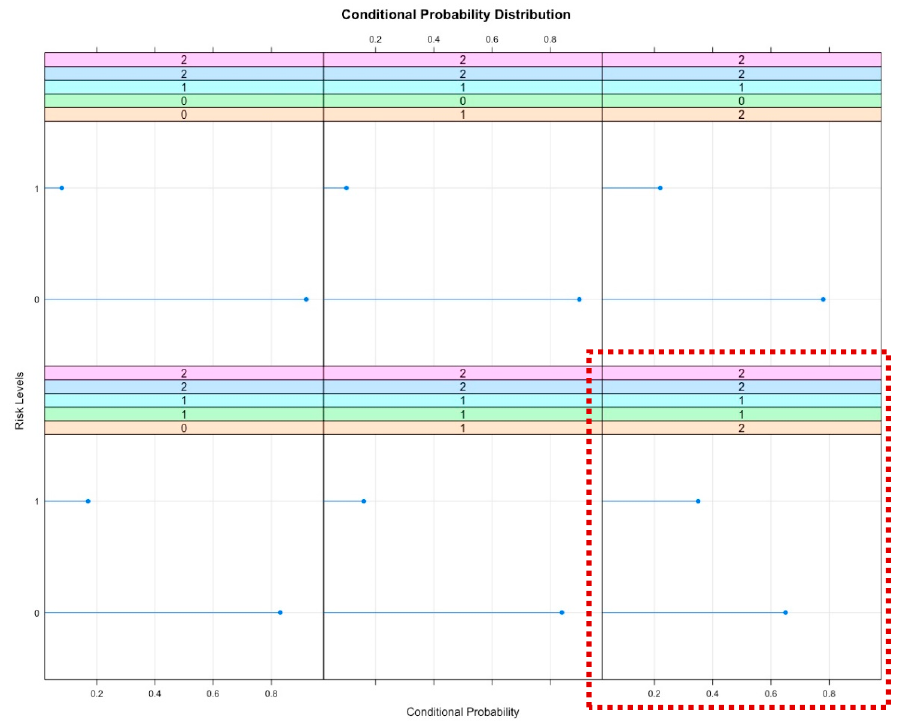
Figure 7. The conditional probability distribution of ‘Cargo Theft Risk’ node using the combination of structure learning algorithm with HC, the score function with k2, the parameter learning algorithm with Bayesian posterior probability estimation and five as the maximum number of father nodes. The subfigure in the bottom right corner (highlight in the red and dotted rectangle) of Figure 7 indicates that the cargo theft risk is highest when ‘Cargo Weight Deviation’ equals 2, ‘Means of Payments’ equals 2, ‘Reformed or Not’ equals 1, ‘Arrival time’ equals 2 and ‘Weather’ equals 1. In other words, this means that when a reformed truck arrives at the port between 10 p.m. and 6 a.m. to pick up a delivery of prepaid cargo and the cargo weight deviates greatly from the normal value, then there is a significant fraud risk of bulk cargo theft. 4.4.3. Model Validation and Model Testing Cross-validation is performed for model validation. Figure 8 and Figure 9 respectively present the predictive error of cross-validation using Bayesian posterior probability estimation and Maximum Likelihood estimation.